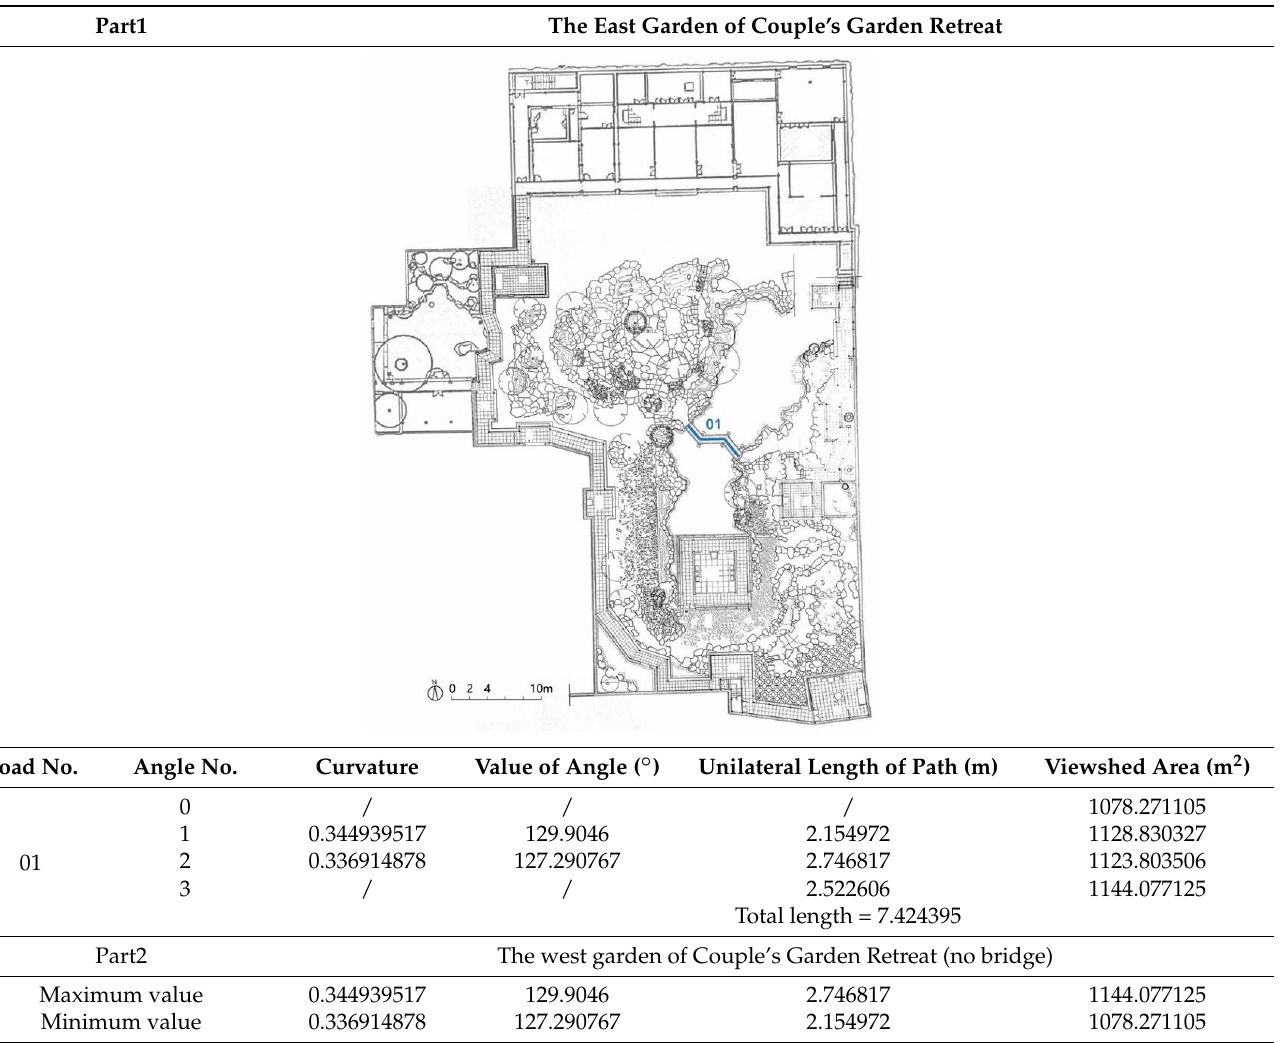
Table A27. Couple’s Garden Retreat, bridge.